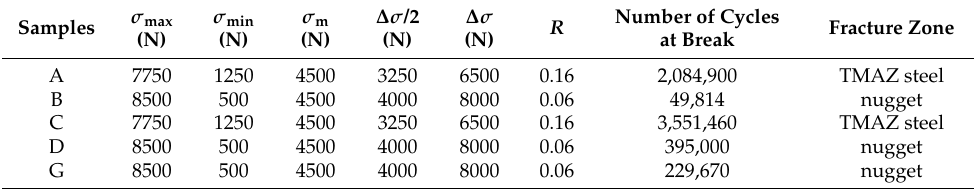
Figure 12. Fracture zone for welding 957 specimen ( a ) and welding 3 specimen ( b ). Table 5. Fatigue test process parameters and results on sample